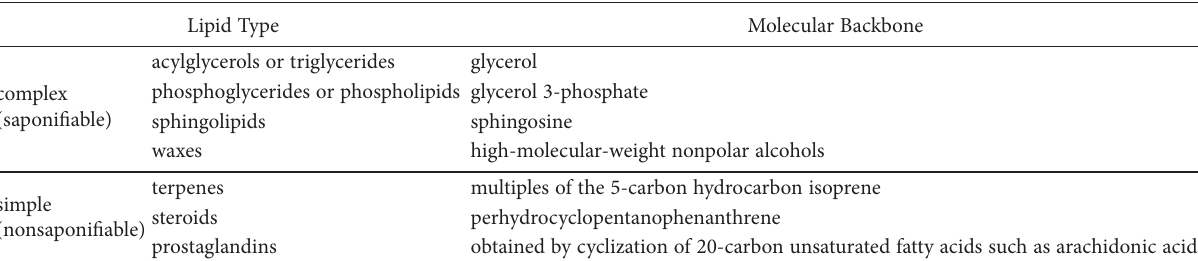
Table 1. Lipid classification according to their backbone structure. 1 The saponifiable lipids can be hydrolyzed to their building blocks which include fatty acids, while the nonsaponifiable lipids cannot be hydrolyzed. Triglycerides are the most numerous in nature. Phospholipids are the main constituents of cell